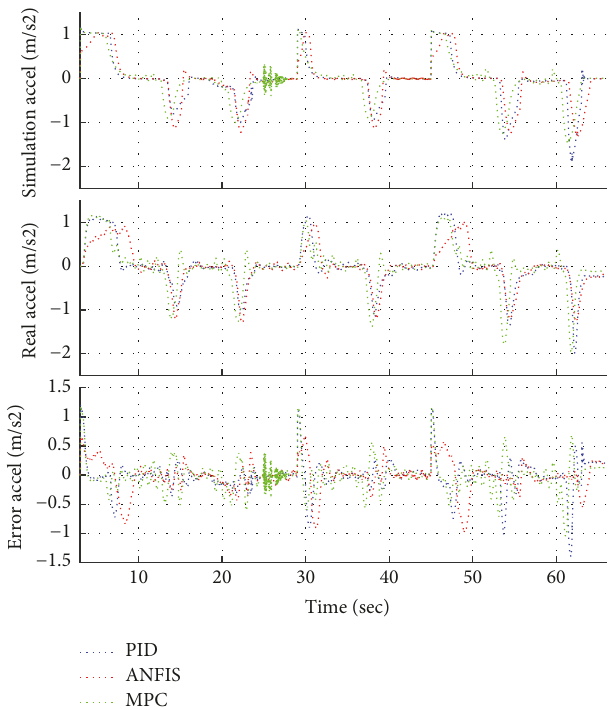
Figure 10: Acceleration response in simulation and real vehicle.